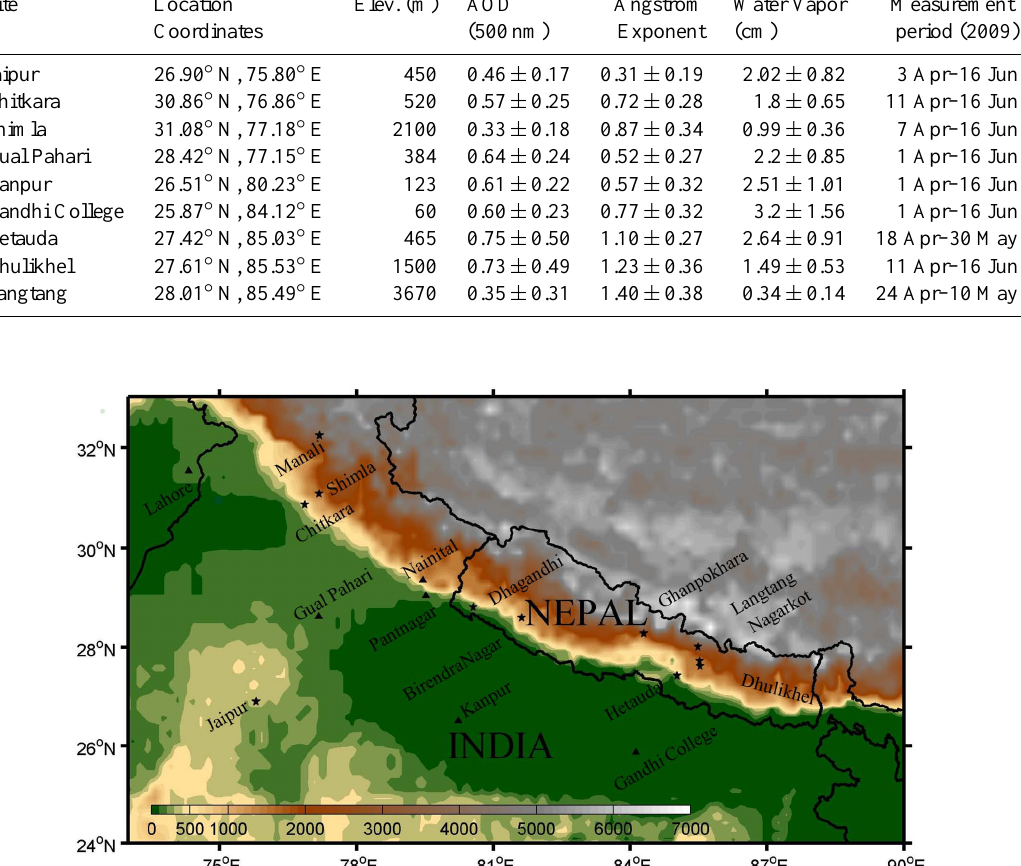
CIMEL and Microtops sunphotometer are shown in Fig.